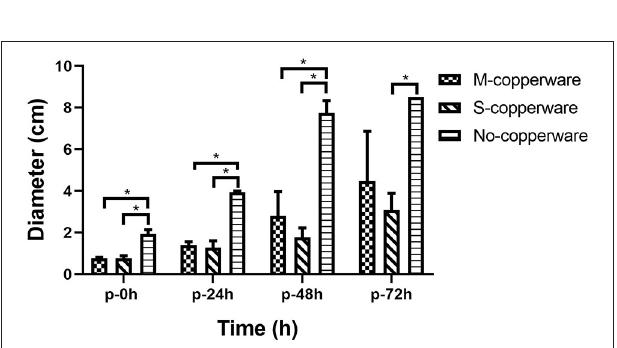
FIGURE 5 | Post-effect of different quantities of COPPERWARE ® (M-copperware: 7.5 × 3.7 × 1.2cm, 4.96g; S-copperware: 3.75 × 3.7 × 1.2cm, 2.58g; No-copperware: control group with no CCCSNs in the filter) on the development of S. parasitica . *: 0.001 < p < 0.05. p : post effect after the removal of the COPPERWARE ® . Error bars are ± SD, n =